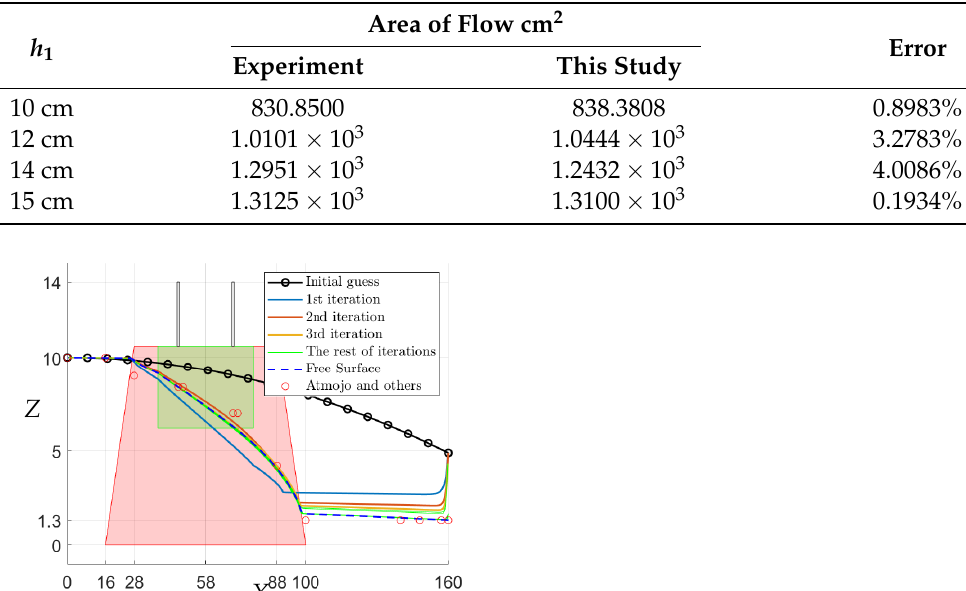
Table 2. The area of flow of the experiment in [10] and this study.